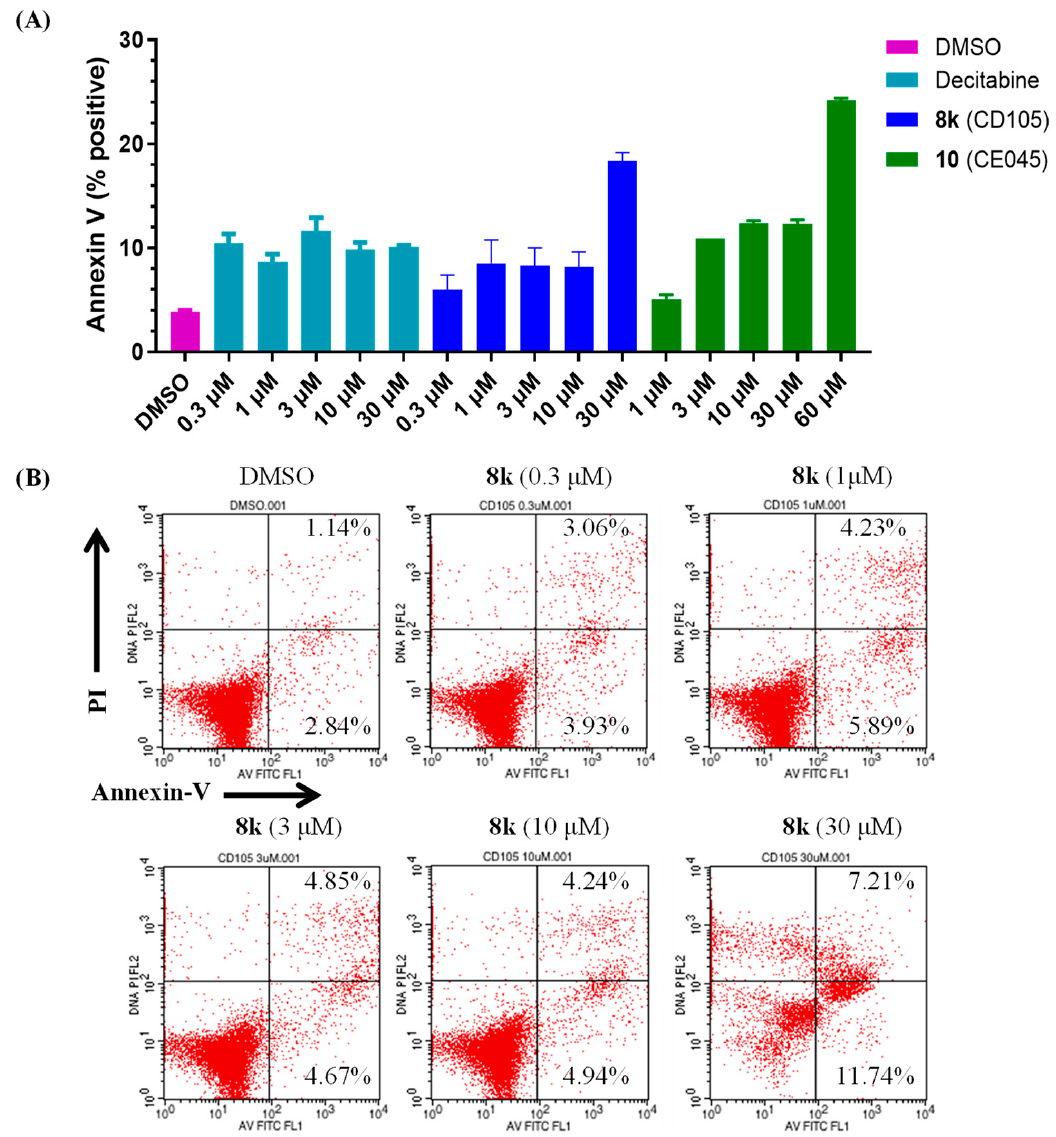
Figure 6. Cytometric flow analysis of apoptosis induction of MV4-11 cells in the presence of 8k (CD105), 10 (CE045), and Decitabine at the indicated concentrations for 48 h. ( A ). Normalized apoptosis induction, ( B ) Apoptosis figures of 8k , while those of 10 and Decitabine can be found in SI Figures S3 and S4. The experiments were repeated twice.